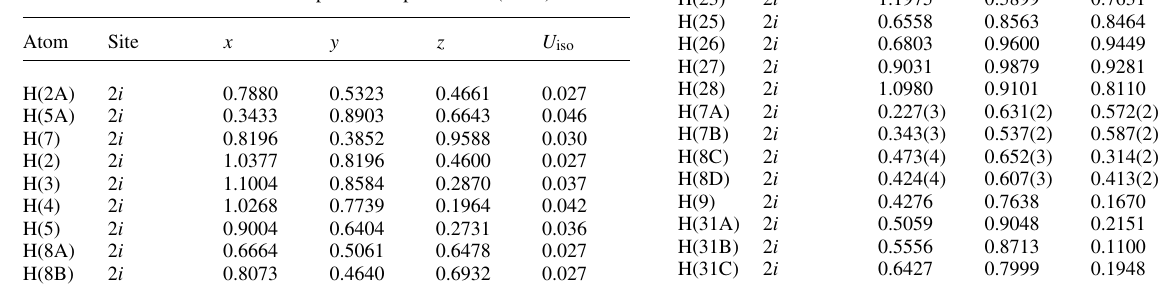
Table 2. Atomic coordinates and displacement parameters (in Å 2 ) .